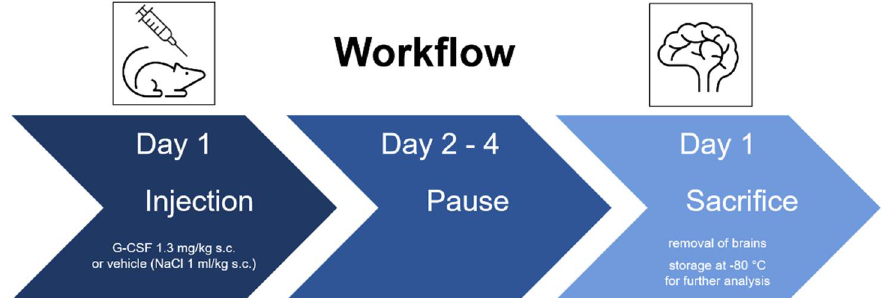
Figure 1 . Outline of experimental procedure. Injections (subcutaneous (s.c.)) of granulocyte-colony stimulating factor (G-CSF) (1.3 mg/kg) or vehicle 0.9% NaCl (1 mL/kg) were performed to observe the effects of a single G-CSF administration upon the rodent brain. Rats were sacrificed on day 5 after drug administration, brains were removed, and stored at −80 °C for subsequent mRNA and protein expression analysis.